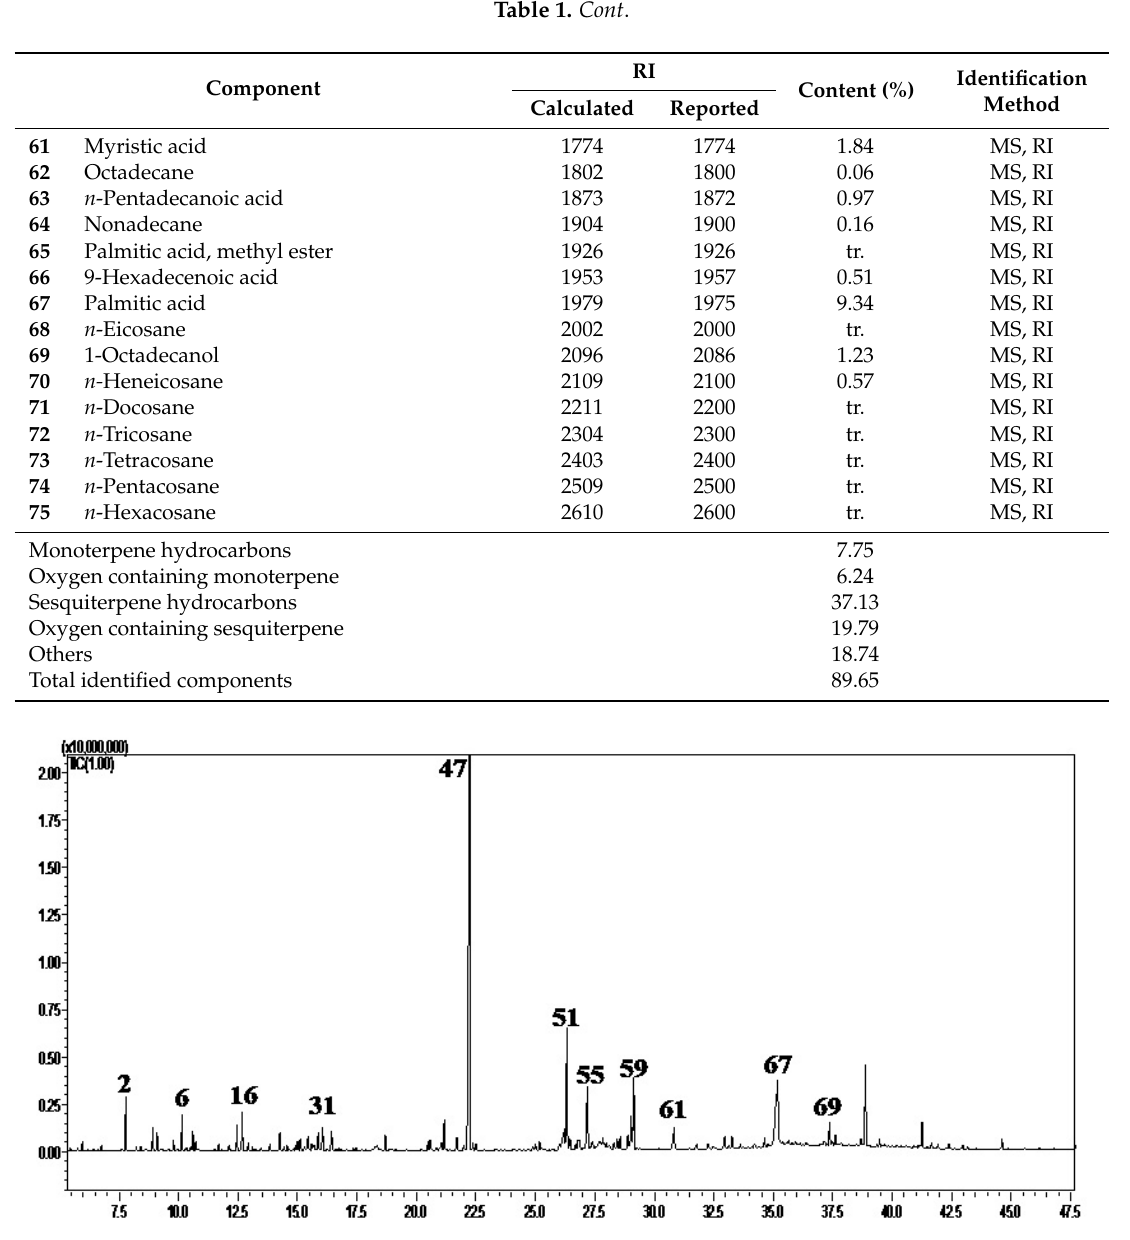
Figure 1. GC-chromatogram obtained with a Rtx-5MS column of the essential oil constituents isolated by hydrodistillation from Pinus roxburghii bark.